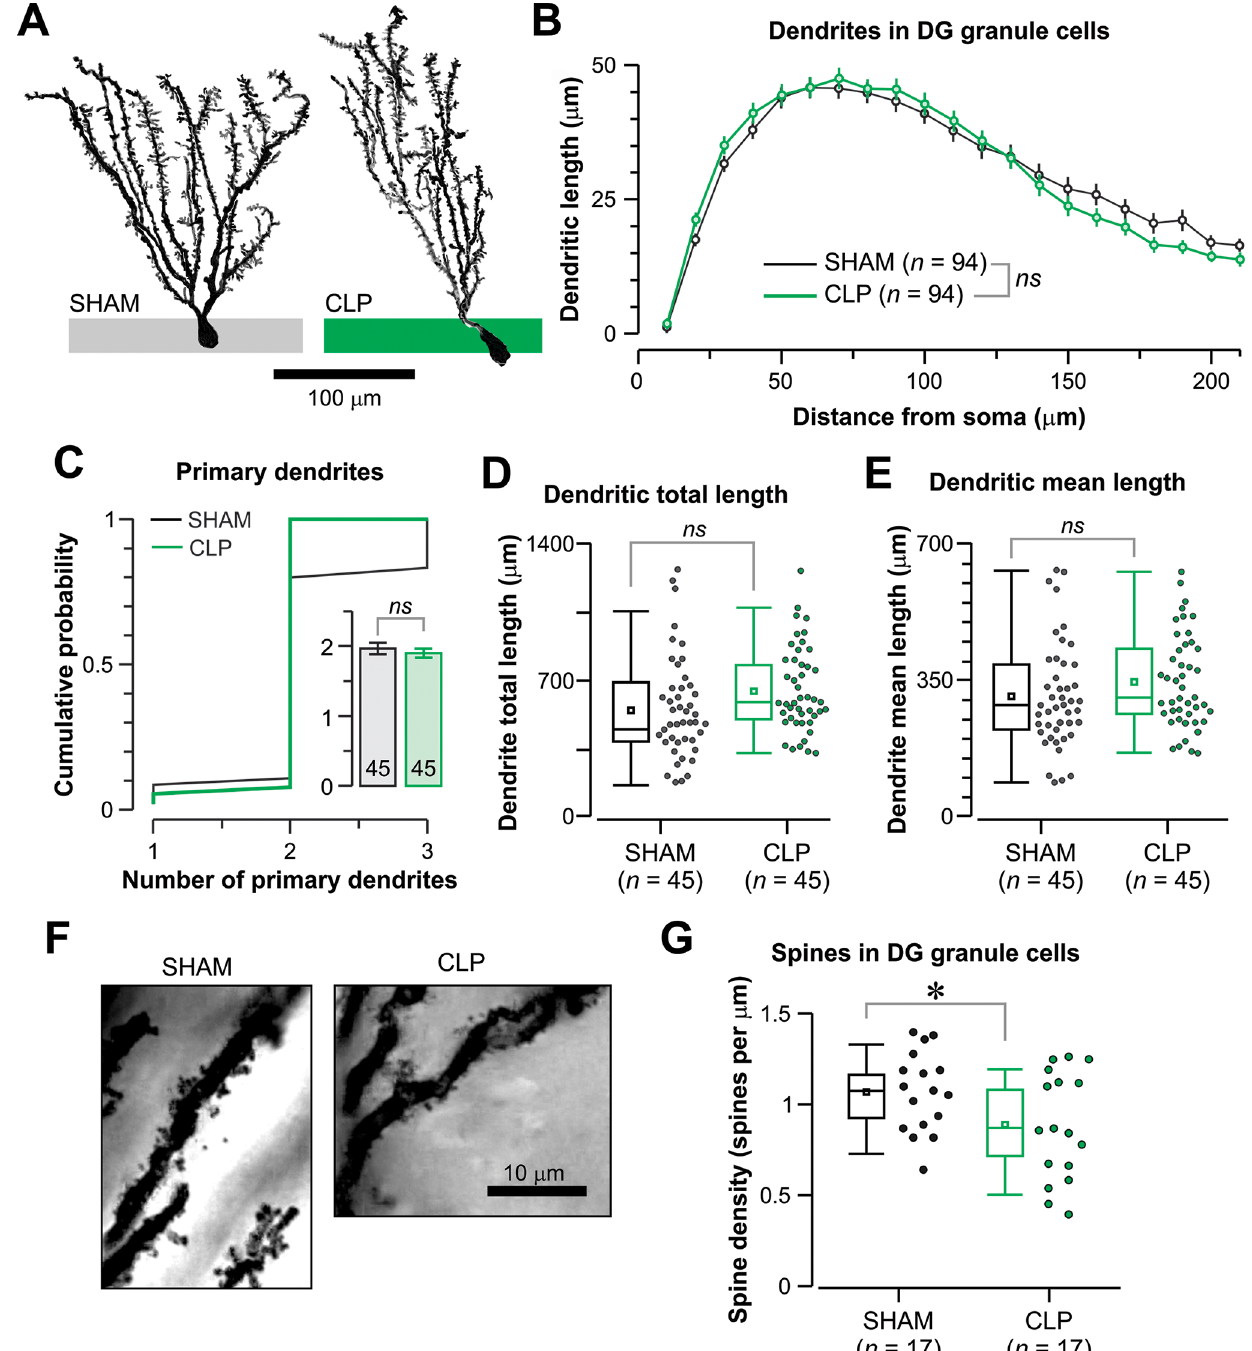
Figure 6. Altered dendritic spine density of DG neurons in CLP-exposed mice. (A) Traces of representative Golgi-stained dentate neurons from the sham and CLP groups. (B) The graph shows the length of DG dendrites (obtained from Sholl analysis) versus distance from the cell body. Values are not significantly different between groups ( ns , not significant; P = 0.98, D = 0.14, Z = 046, Kolmogorov-Smirnov test). (C) The graph shows that the cumulative probability of the distribution of primary dendrites for both groups is comparable (inset shows box plots; ns, P = 0.47, t test). (D–E) Box plots of dendritic measurements are comparable for total length (D, ns, P = 0.09, t test) and mean length (E, ns, P = 0.18, t test). (F) Micrographs show dendritic spines in DG dendrites. (G) The box plot of spine density shows that the CLP group has significantly fewer spines than the sham group. Statistics, * P < 0.05 by t